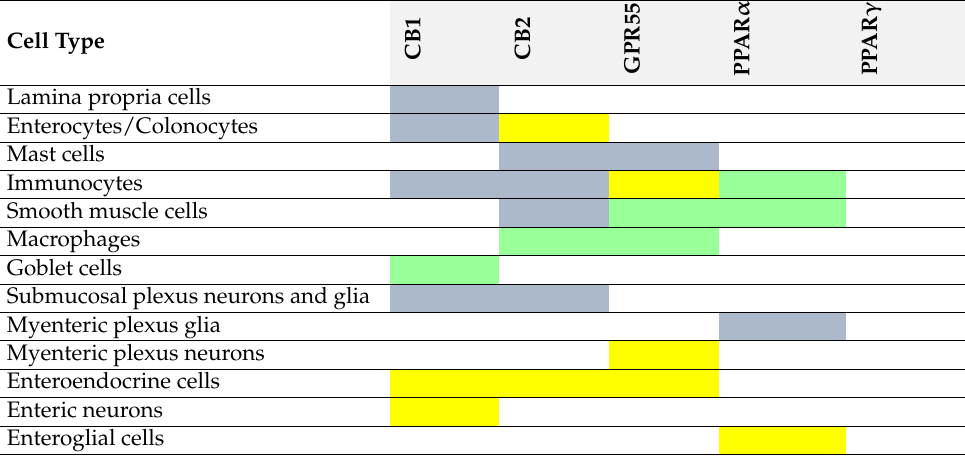
Table 1. Main distribution of the investigated eCBome receptors in the gastrointestinal (GI) tract of either dogs (grey), cats (yellow) or both species (green). Modified from